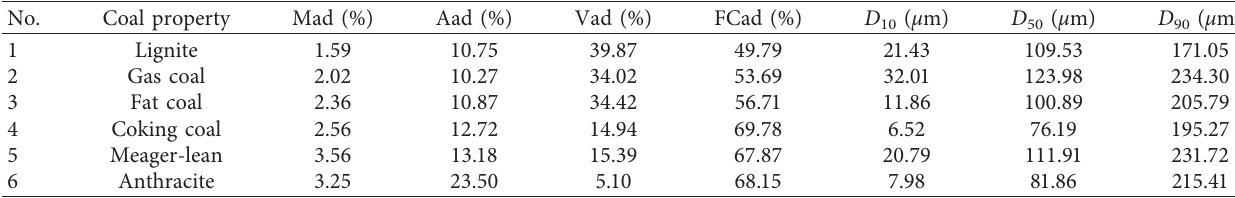
Table 1: Industrial analysis indexes and characteristic particle sizes of experimental coal samples.